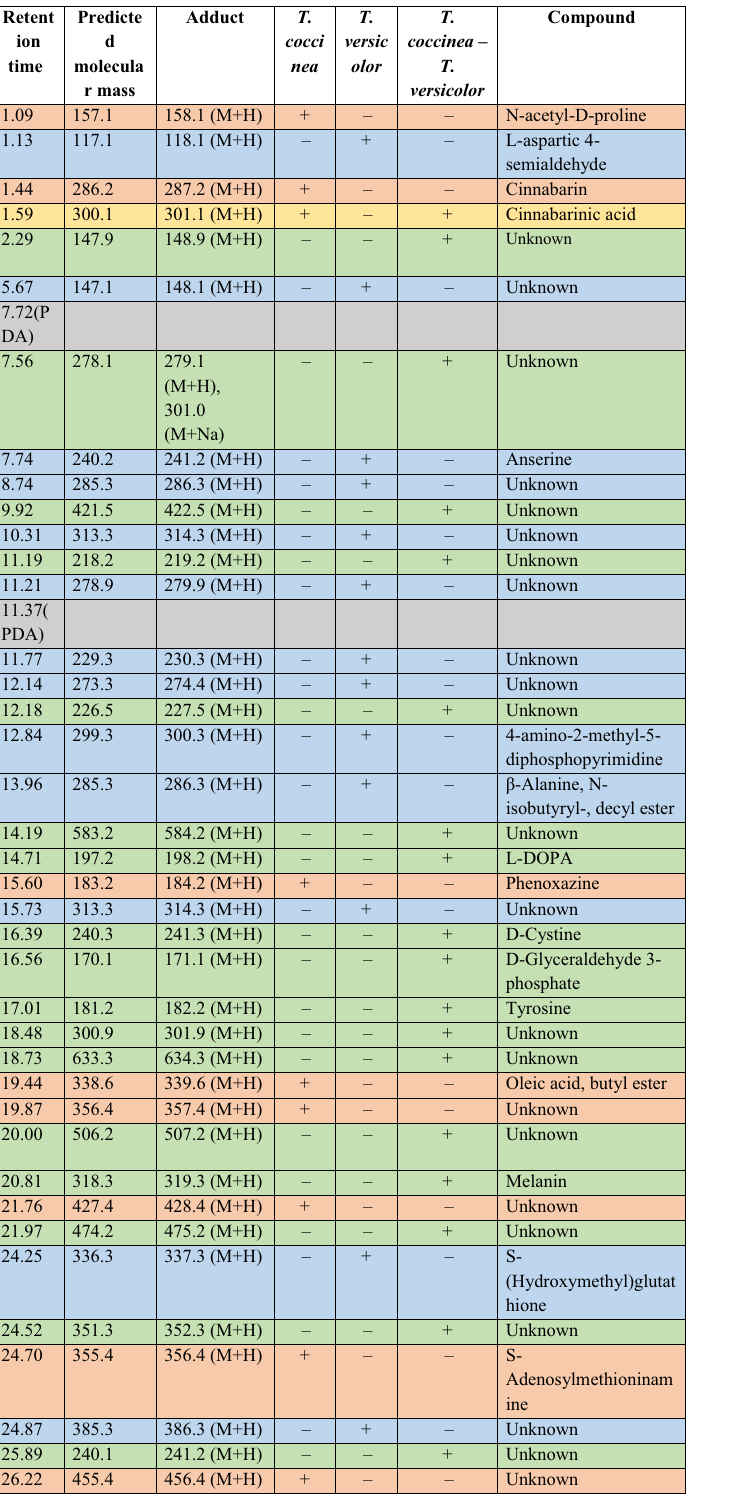
Table 1 Comparative analysis of metabolite profiles during interspecific interactions between T. coccinea – T. versicolor Retent Predicte ion d time molecula r